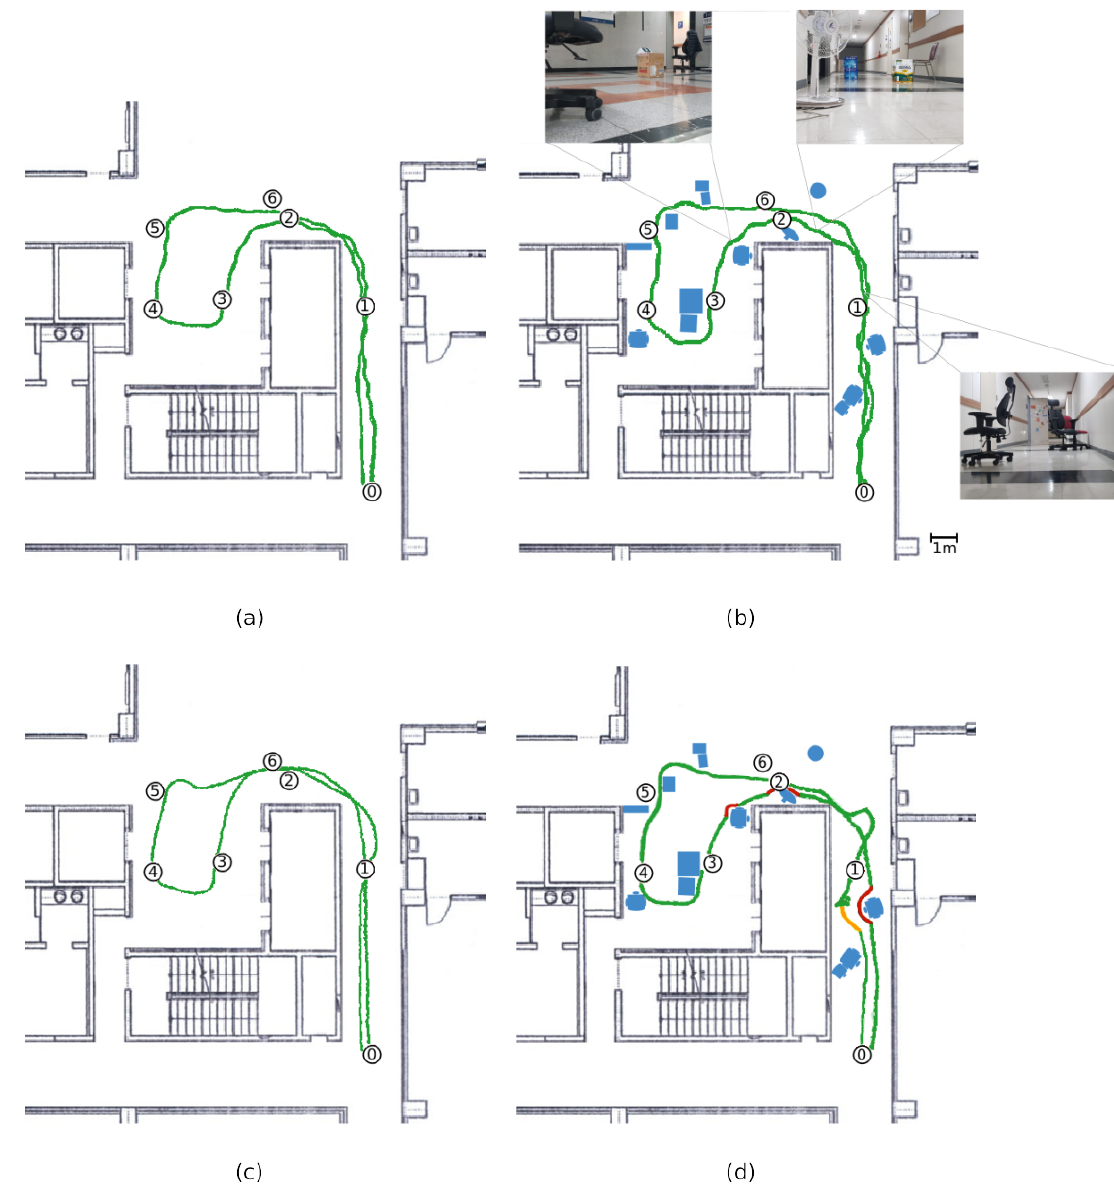
Figure 7. Results in the real environment. The green path depicts the robot’s movements from odometry data. Red parts of the path show the human intervention after a crash. The orange part of the path shows the human intervention after the robot encountered a deadlock. Blue shapes depict the location and shape of the obstacles. Numbers from 0 to 6 describe the locations and sequence of the target goals. Images show the robot’s view of the environment at the location. ( a ) CDDPG performance in an environment without added obstacles; ( b ) CDDPG performance in an environment with added obstacles; ( c ) ADDPG performance in an environment without added obstacles; ( d ) ADDPG performance in an environment with added